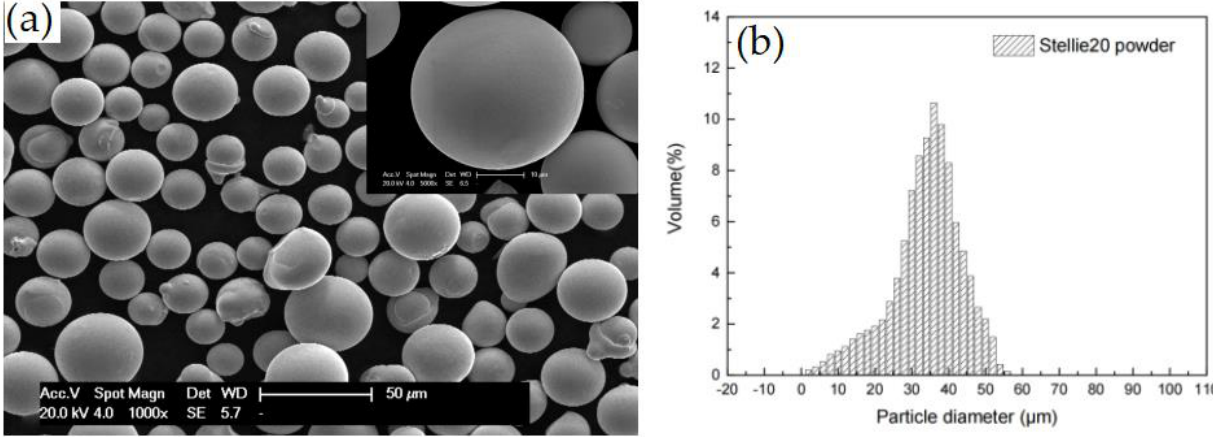
Figure 2. ( a ) The morphology of Stellite 20 powder and ( b ) particle size distribution of the feedstock